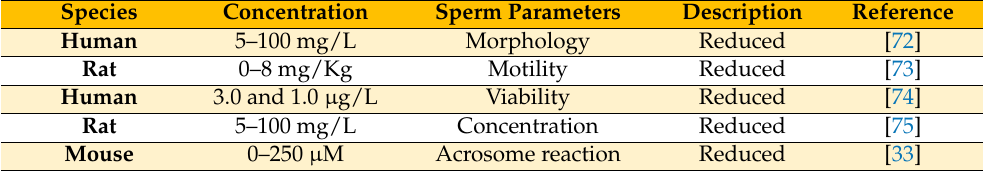
Table 2. Effect of cadmium toxicity on sperm